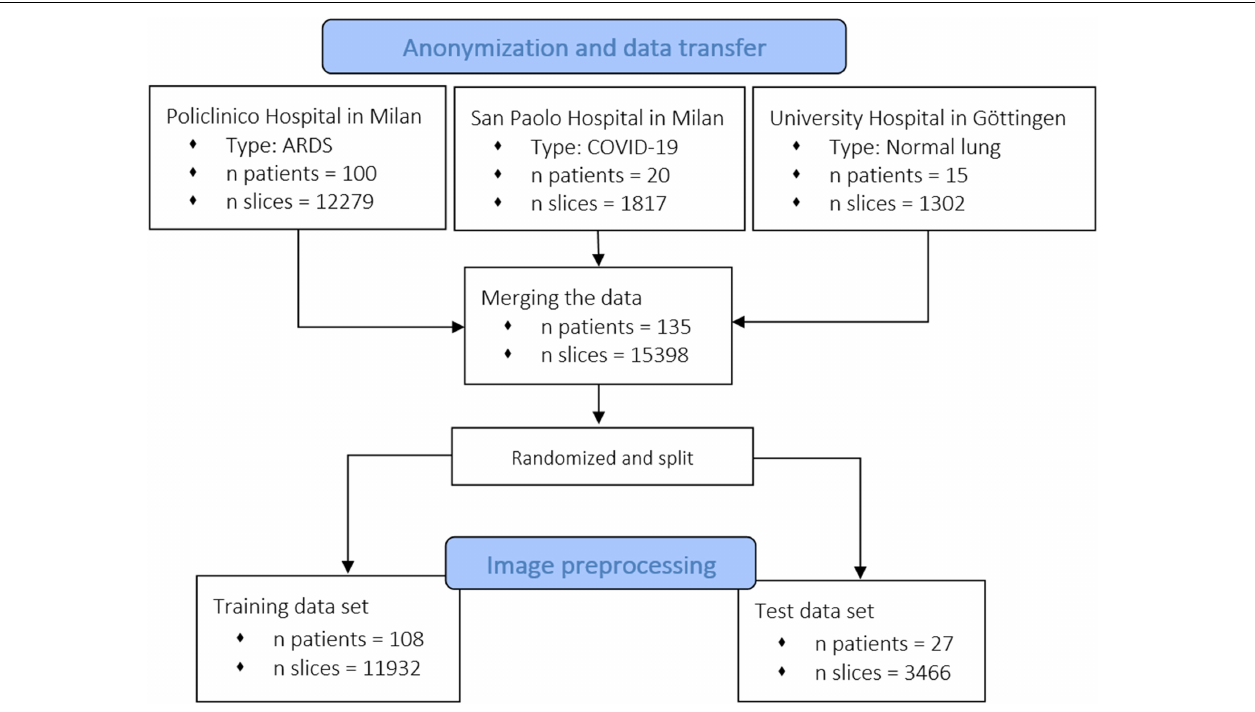
FIGURE 1 | Flowchart of the inclusion of patients and related CT scans. We collected data from different centers, from healthy and acute respiratory distress syndrome (ARDS) lungs. As shown, the model was also trained and tested with recently acquired COVID-19 lungs.